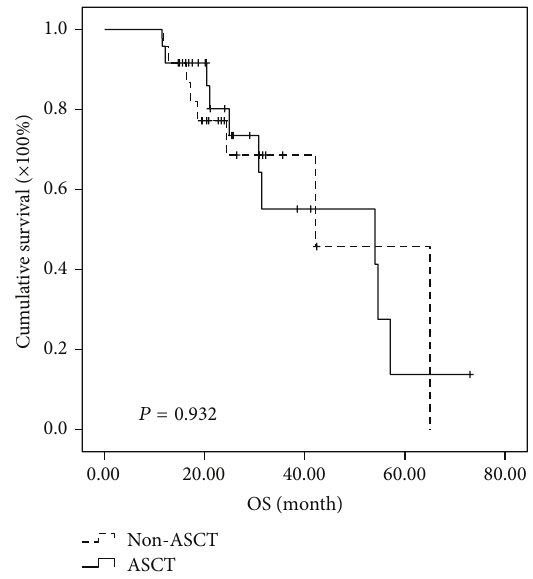
Figure 4: Comparison of OS in the patients of ASCT group and non-ASCT group in the high-risk subgroup. The median OS was prolonged 51.5 months in ASCT group (85.5 versus 34 months, 𝑃 = 0.015 ).